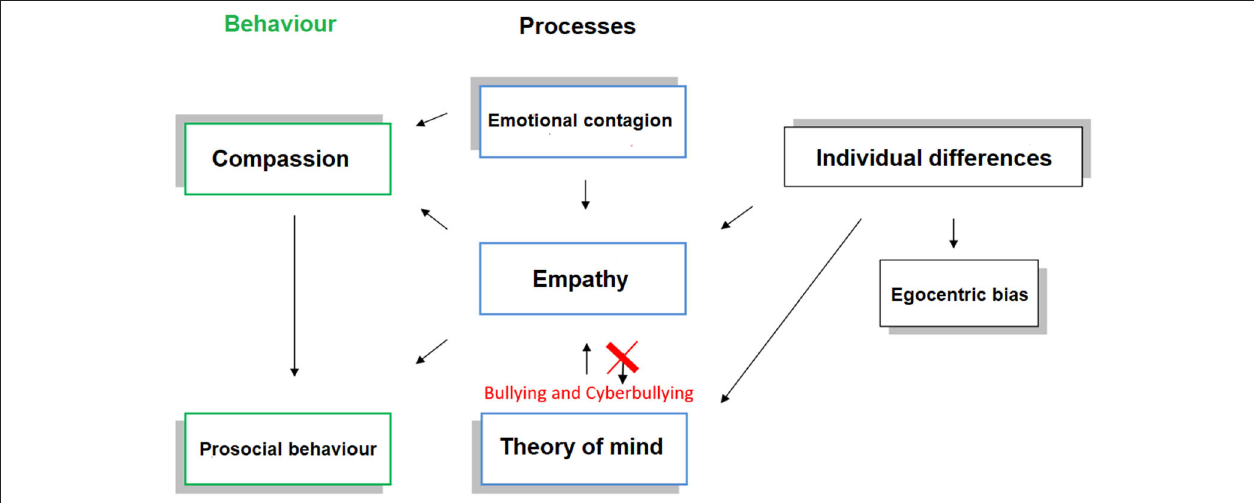
FIGURE 1 | The representation of the model indicates the relationship between the various elements: emotional contagion, empathy, theory of mind, compassion, pro-social behavior, egocentric bias and individual characteristics. Prosocial behavior is the antagonist of cyberbullying, in fact it is possible only by the empathic process that emerges through different processes and influenced by individual indifferences and egocentric bias. The phenomenon of cyberbullying emerges from the breaking point between the theory of mind and